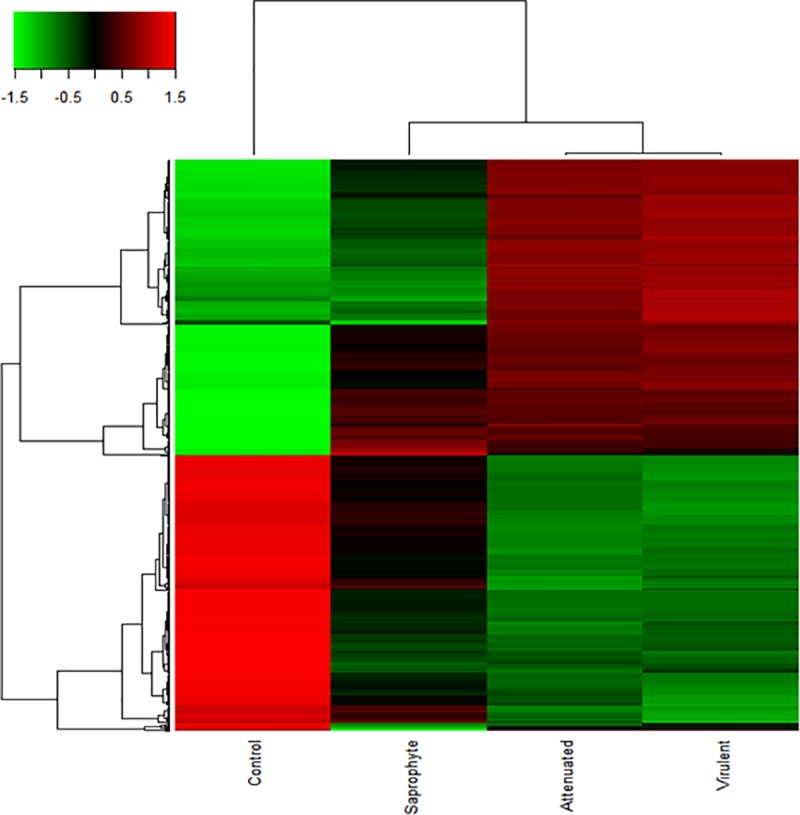
Heatmap of differentially expressed genes shows the average signal by macrophages at 6 hours of infection in different strains of Leptospira spp.The red color indicate increased expression, green color indicates the decreased expression as compared to control (n = 3/treatment; p-value<0.01; FDR<0.05; linear fold change ± 2).